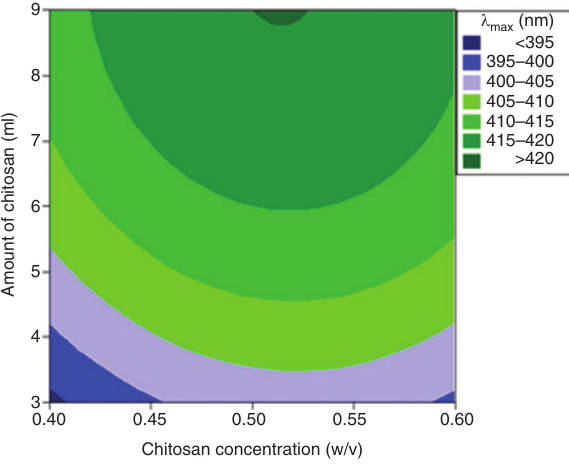
Figure 5: Contour plot for concentration (ppm) of the synthesized silver nanoparticles (AgNPs) solution as function of the amount and concentration of chitosan